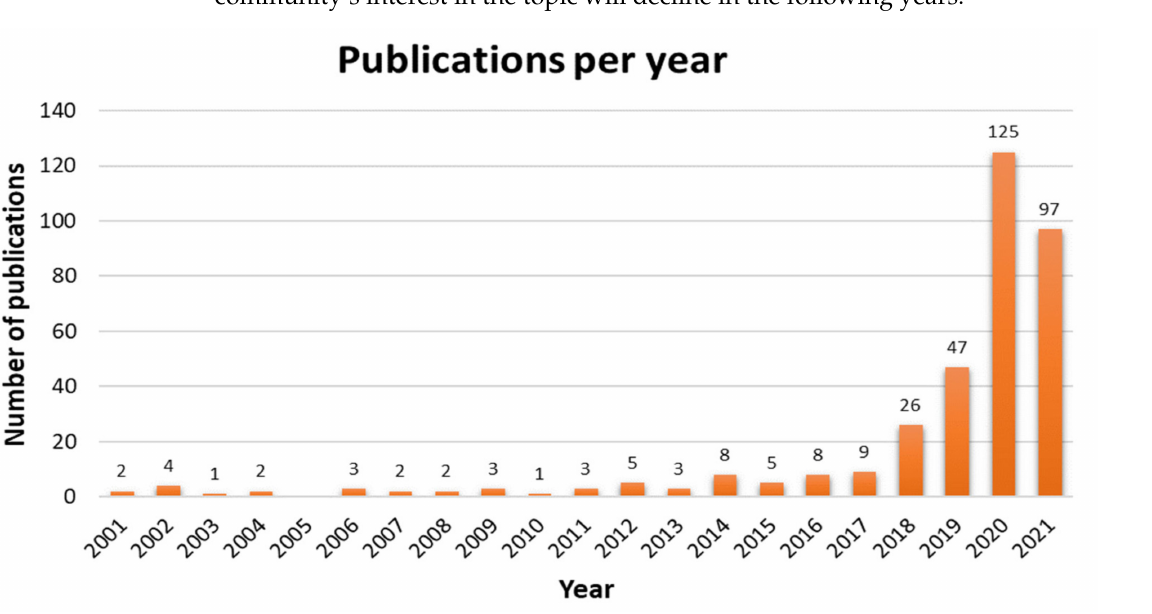
Figure 1. Micromobility-related publications per